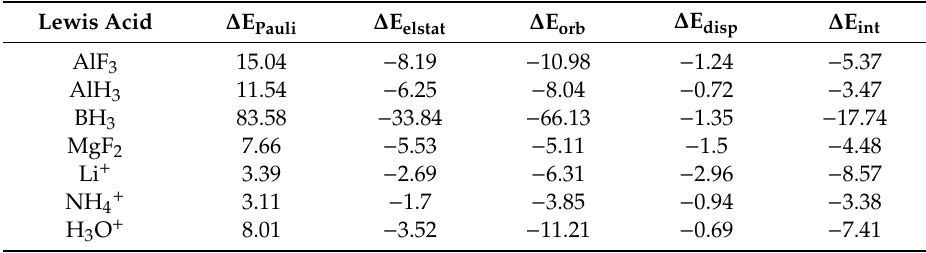
Table 5. The energy terms for selected complexes resulting from the decomposition of the energy of interaction (in kcal / mol); ∆ E Pauli —the Pauli repulsion, ∆ E elstat —the electrostatic term, ∆ E orb —the orbital interaction energy, ∆ E disp —the dispersion interaction energy term, and ∆ E int —the total interaction